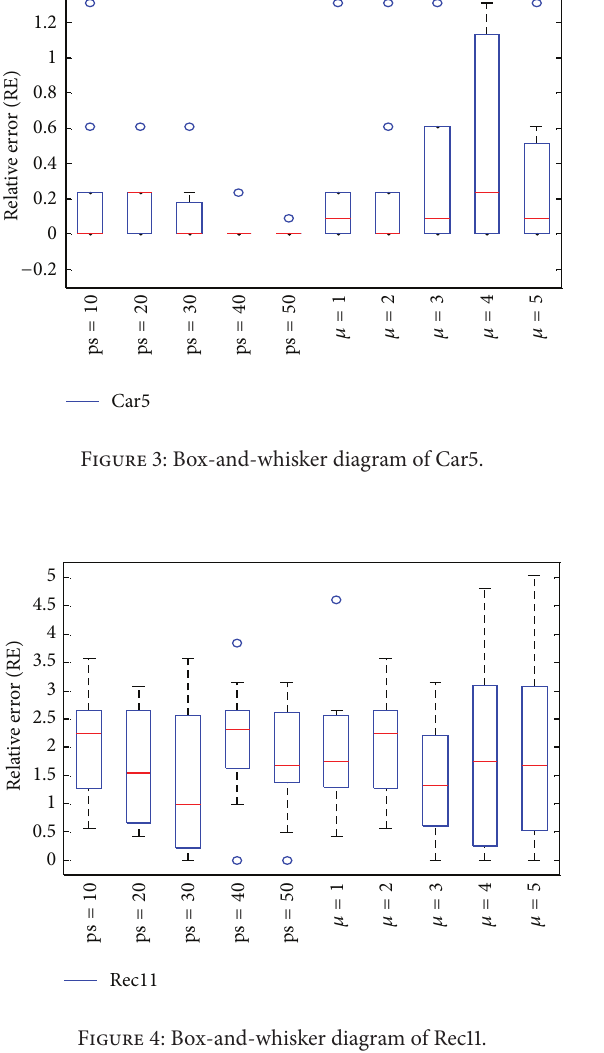
Figure 4: Box-and-whisker diagram of Rec11.